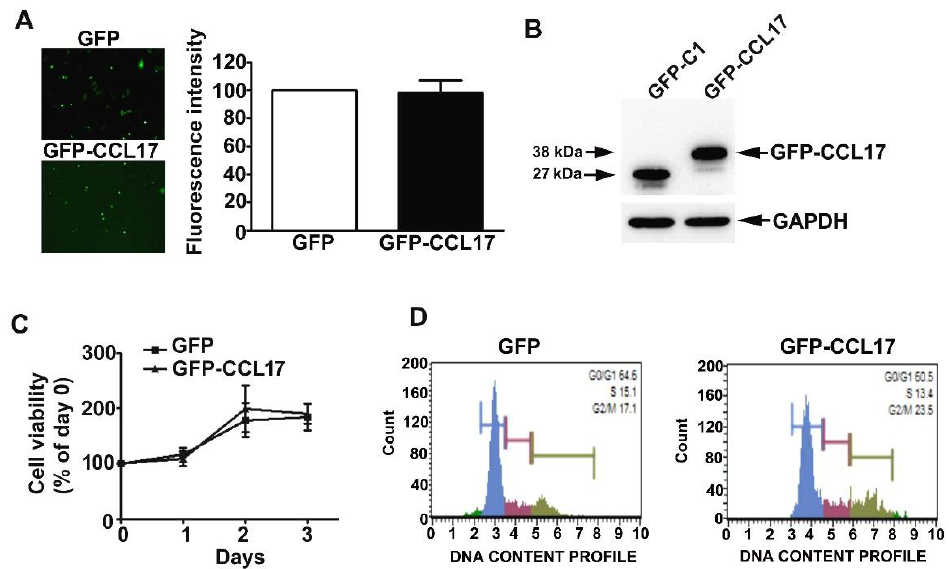
Figure 2. Effects of overexpression of CCL17 on the viability and proliferation of HK2 cells. GFP- or GFP-CCL17 plasmids were transfected into HK2 cells for 48 h. ( A ) Transfection efficiency as determined using fluorescence microscopy. Data are expressed as a percentage of the fluorescence intensity as compared with the GFP cells ( B ) CCL17 protein expression was detected with GFP antibody by western blotting, relative to GAPDH as the loading control; ( C ) cell growth as assessed by MTT cell viability assay; ( D ) cell cycle distribution as assessed by PI staining and flow cytometry. Results are expressed as the mean ± SD of at least three independent experiments.